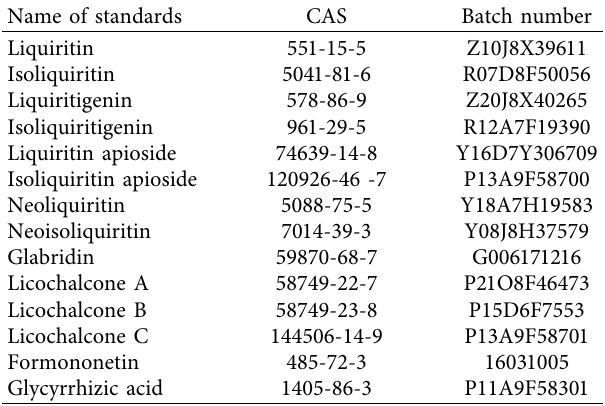
Table 2: The standards of licorice information table. Name of